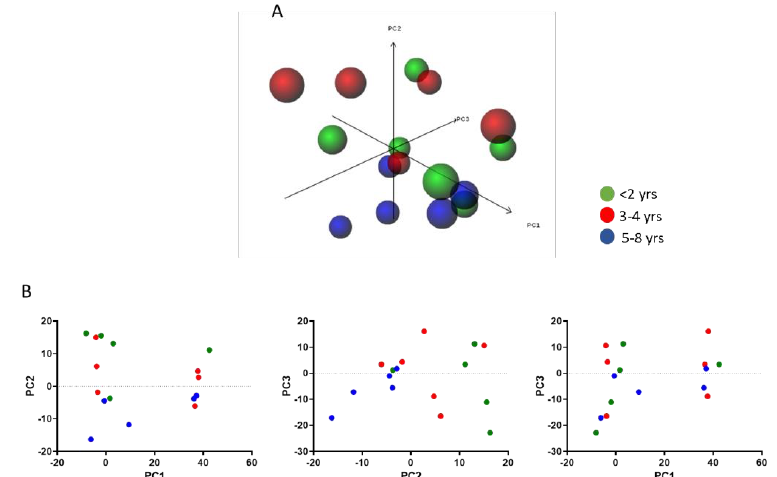
Figure 3. Principal component analysis of MIF network genes in muscle biopsies of DMD patients at di ff erent ages, as determined in the GSE38417 dataset. Samples were divided based on DMD patients’ age: < 2 yrs (green), 3–4 yrs (red), 5–8 yrs (blue). Data points are projected onto principal components (PC) 1, 2, and 3 ( A ). The same data ( B ), projected onto PC1 and 2, PC2 and 3, and PC1 and